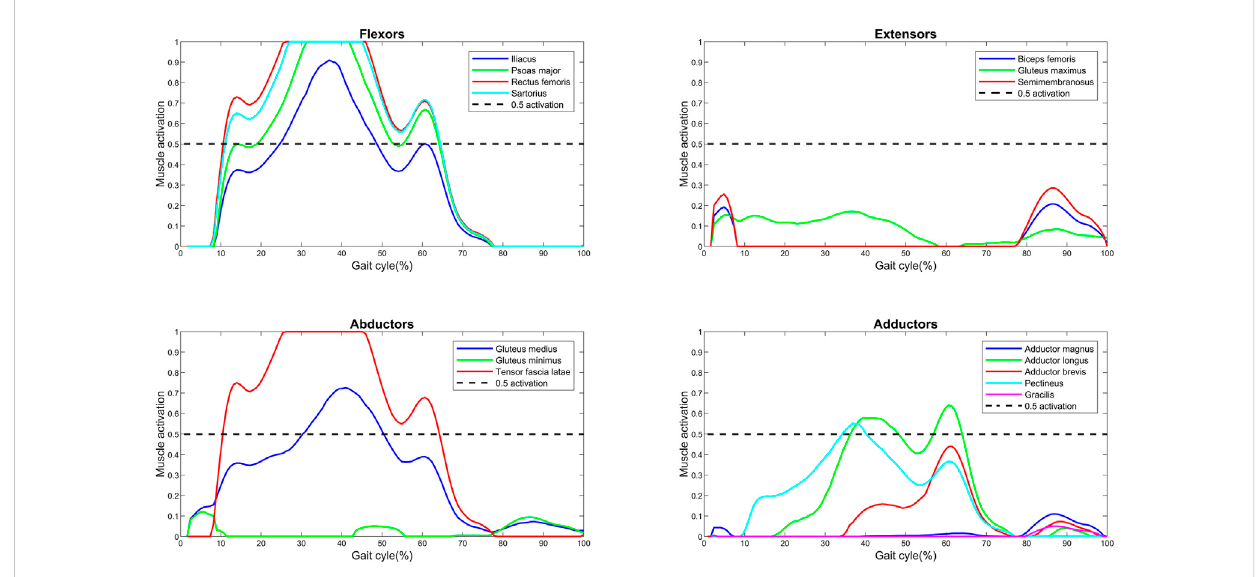
FIGURE 1 Muscleactivations(forcenormalizedto F i max ) overagaitcycleforanindividualwithbilateraltransfemorallimbloss.Musclesaregroupedbyprimary function: fl exors, extensors, abductors, and